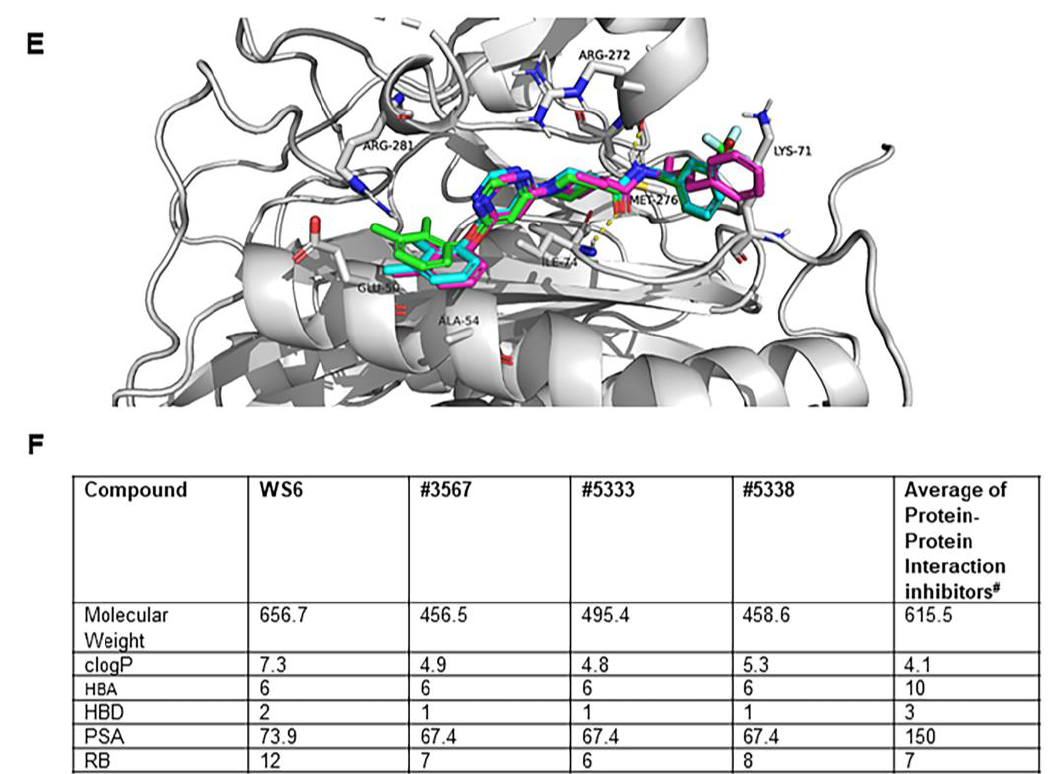
Figure 1. Identification of selective chemical inhibitors of PA2G4-MYCN oncogenic interaction through SAR studies. ( A ) WS6 structure and cytotoxicity in neuroblastoma. ( B ) Core structure of Generation 1 and 2 compounds. SAR comparisons of R1 and R2 substitutes of WS6 hit analogues. ( C ) Representative IC50 plots for WS6, #3567, #5333, and #5338 comparing neuroblastoma cells (Kelly, SK-N-BE(2)-C) to non-malignant myofibroblasts (WI-38, MRC-5). ( D ) Representative Surface Plasmon Resonance curves showing the concentration-dependent binding of #3567, #5333, or #5338 to PA2G4. ( E ) Docking orientation of SVI3567 (green), SVI-5333 (cyan), and SVI-5338 (magenta) in PA2G4 (white). Shown in sticks are the amino acids proposed to interact with the compounds. Specifically, there are hydrogen bonds to the main-chain atoms of Arg272 and Ile74 (shown as yellow dashed lines), and hydrophobic interacts with Ala54, Glu50, Arg281, Met276, and Lys71. Furthermore, there is a putative interaction between the 3-CF3 or 3-Br group of #3567 and #5333 and the backbone carbonyl oxygen of Arg271. ( F ) Summary of the physicochemical properties of the top WS6 analogues. Molecular weight (MW), partition co-efficient (clogP), hydrogen bond acceptors (HBA), hydrogen bond donors (HBD), polar surface area (PSA), and rotatable bonds (RB) were all calculated using Chemaxon Software and compared to the average (median) of all protein-protein inhibitors on the market. Median value of protein-protein interaction inhibitors approved for use [14].